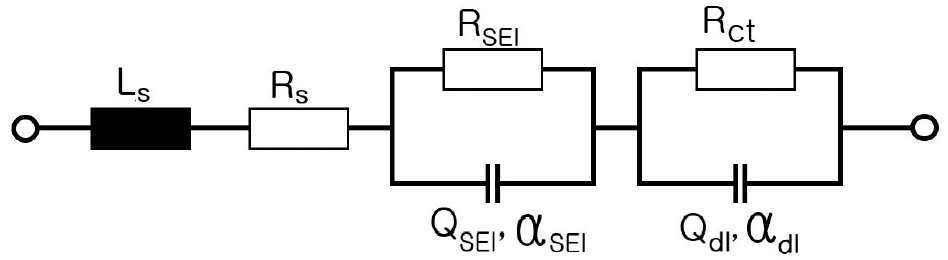
Figure 7. Impedance spectrum according to the presence or absence of charging for a cylindrical Li-ion battery[5].